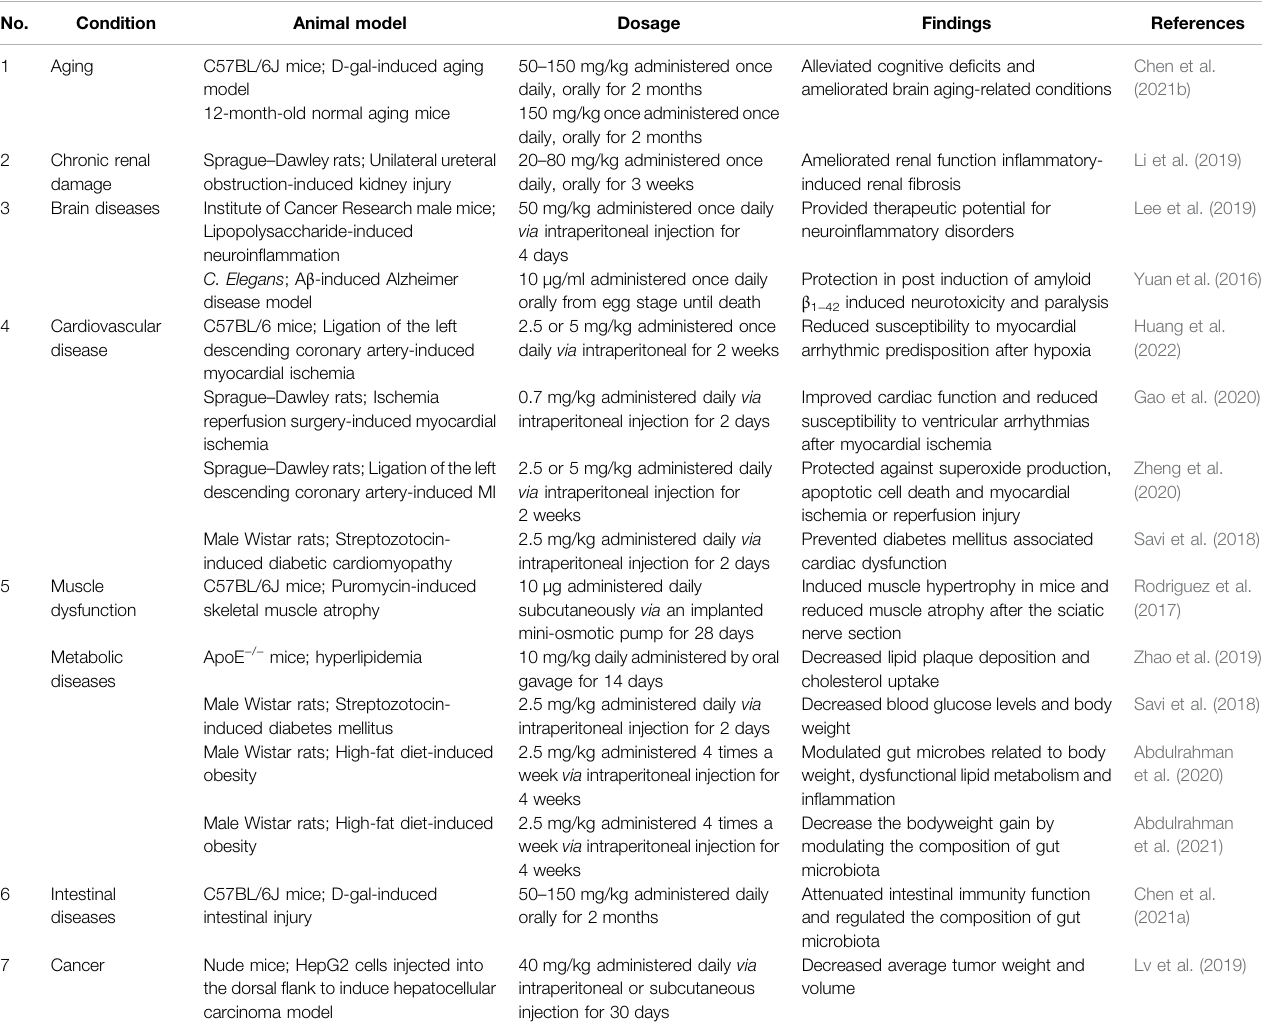
TABLE 1 | Disease state, experimental design and biological activities of Urolithin B in vivo .